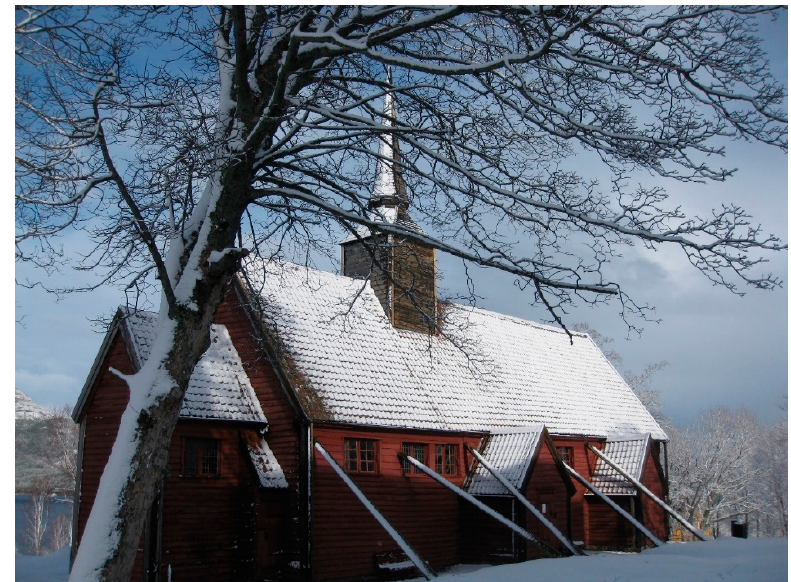
Figure 1. The exterior of Kvernes stave church during one of the rare days with snow (date: 3 March 2011). Photo © Norwegian Institute for Cultural Heritage Research (NIKU) 2011.